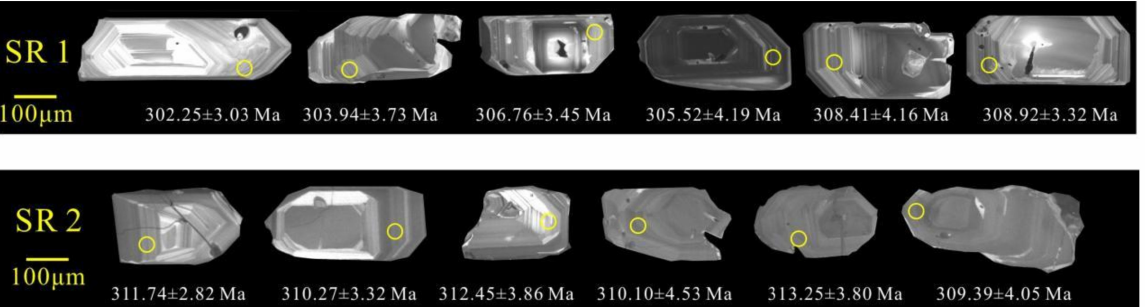
Table 2. Results of the zircon LA–ICP–MS U–Pb dating results for SR2 and SR1 in the Sayashk district.